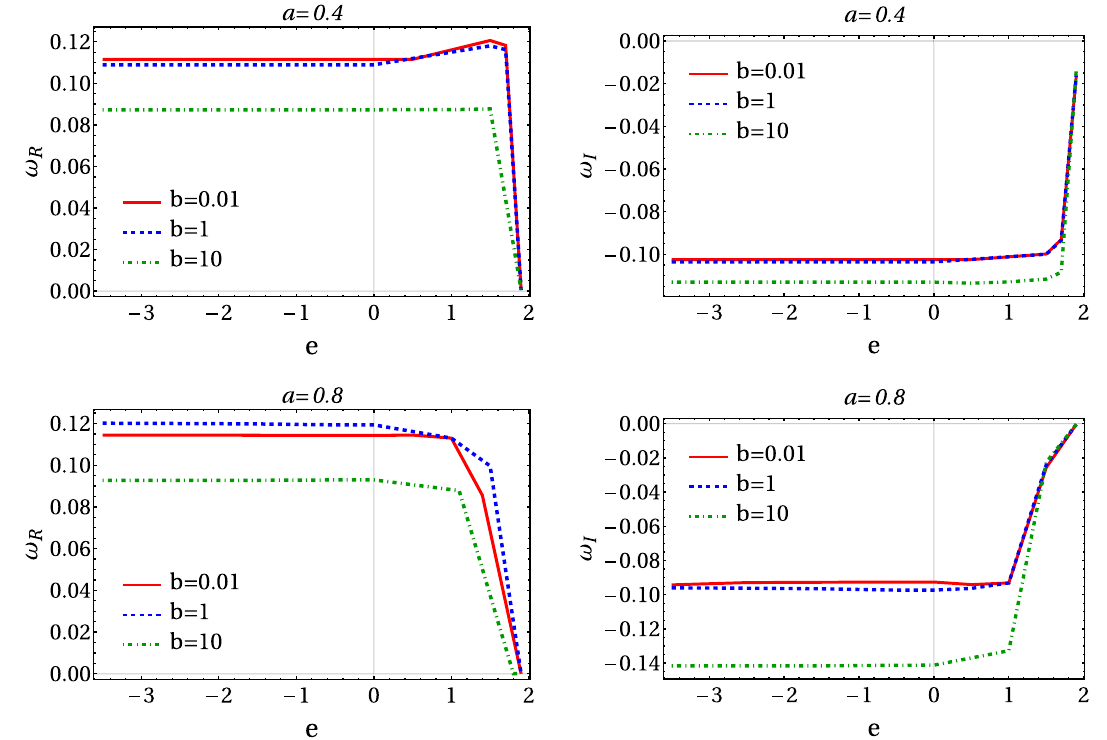
Fig. 1 The variation of both real (left panel) and imaginary parts (right panel) of (cid:15) = 0 scalar QNM modes are shown. The parameters are taken √ to be: M = 1, a ∈ { 0 . 4 , 0 . 8 } , e ∈ ( − 3 − 3 / 1 − a 2 , 2 ] , and b ∈ { 0 . 01 , 1 , 10 }